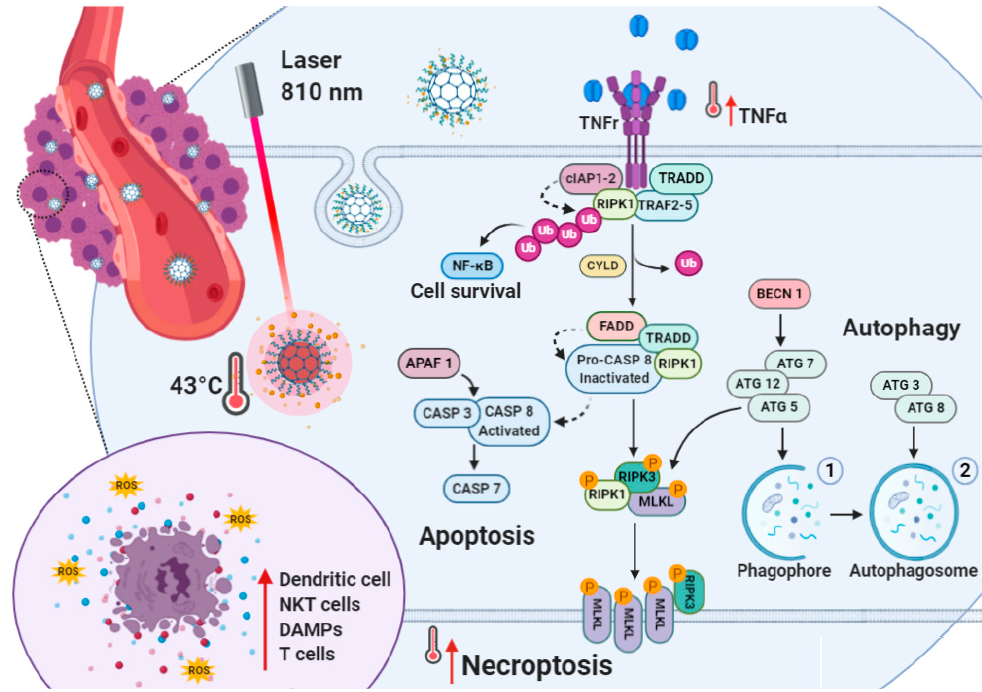
Figure 1. Near-infrared (NIR)-triggered photothermal action in MDA-MB-231 and MCF7 cell